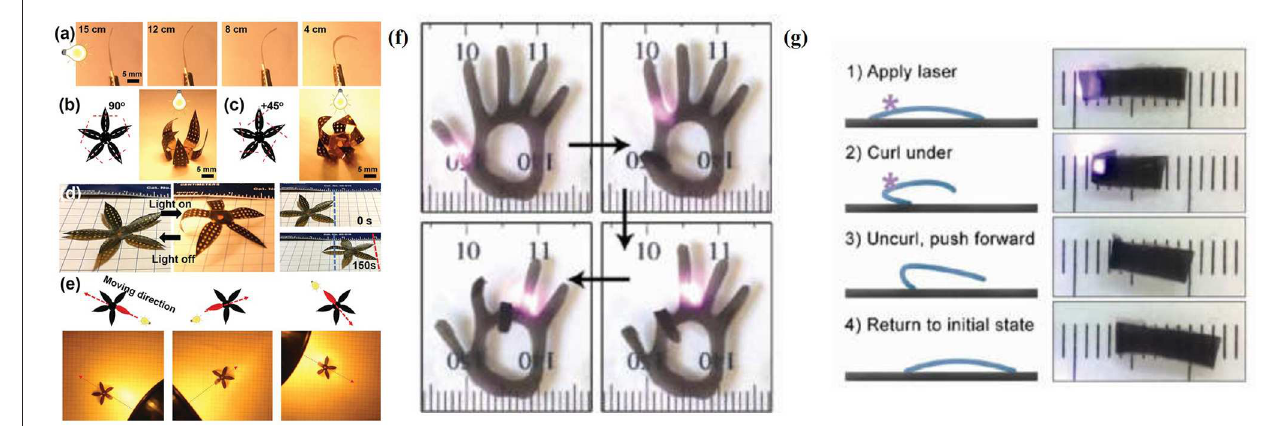
FIGURE 8 | (a) Photographs of a PLP actuator upon exposure to light with different distances. (b,c) Photographs of a flower-shaped PLP actuator with (b) y = 901 and (c) y = + 451 when exposed to light. (d) Photographs of a PLP robot crawling by switching the light on and off. (e) Schematic and photographs of a PLP robot with multi-way gaits under light stimulus (reproduced from Deng et al., 2018 with permission from The Royal Society of Chemistry). (f) Images of the fingers of a hand-shaped rGO-ELP hydrogel controllably bending and unbending in response to the location of an IR laser spot. (g) Schematic and images of a light-driven crawler. A rGO-ELP hydrogel molded with a slight curvature was placed with the porous side facing down. The laser was applied so as to induce gel curling. Subsequent uncurling during recovery after the laser was removed pushed the gel forward (1mm tick marked) (reprinted with permission from Wang E. et al., 2013. Copyright 2013 American Chemical